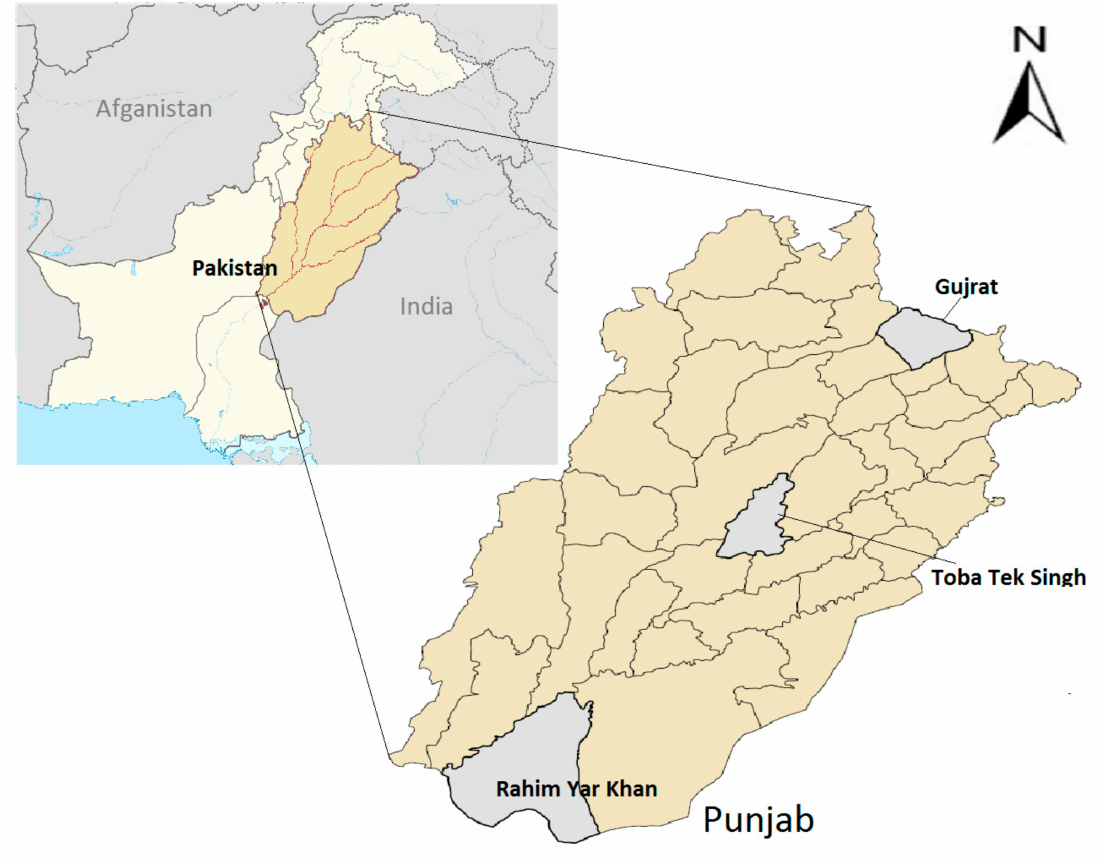
Figure 1. Case study area map, Punjab,